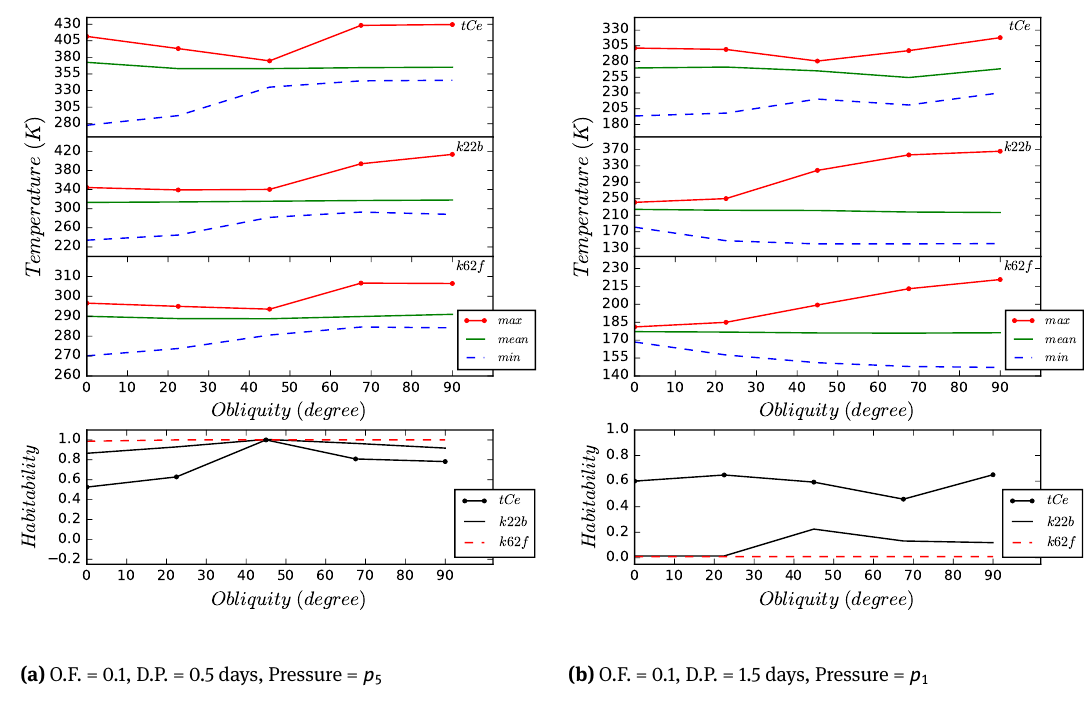
(a) O.F. = 0.1, D.P. = 0.5 days, Pressure = p 5 (b) O.F. = 0.1, D.P. = 1.5 days, Pressure = p 1